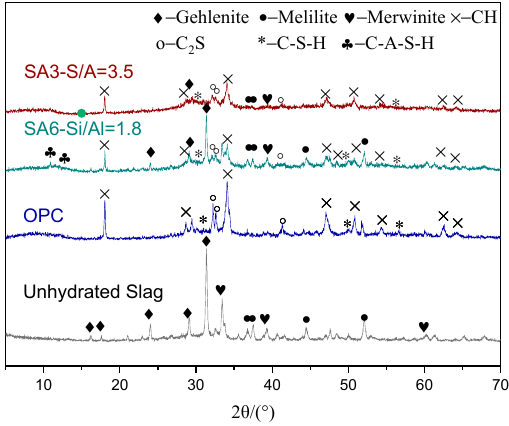
Figure 9. The evolution of the polymerization state of silicon tetrahedron at a 3-day age: ( a ) stacking chart; ( b ) SA1; ( c ) SA5; ( d ) SA9. 357